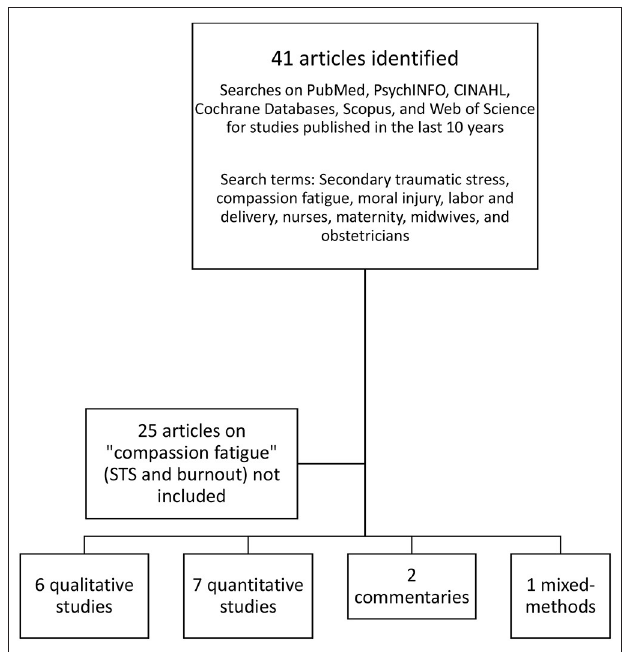
FIGURE 1 | Articles included in